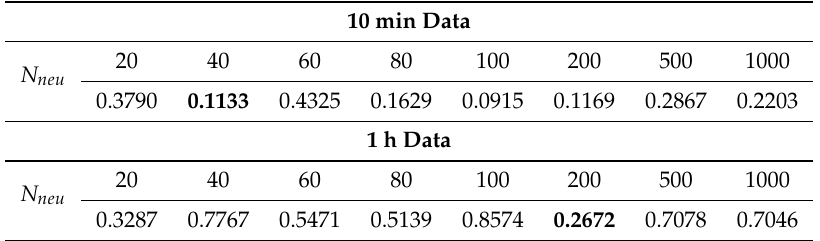
Table 8. Single ELM model selection for wind speed time series at the GS site